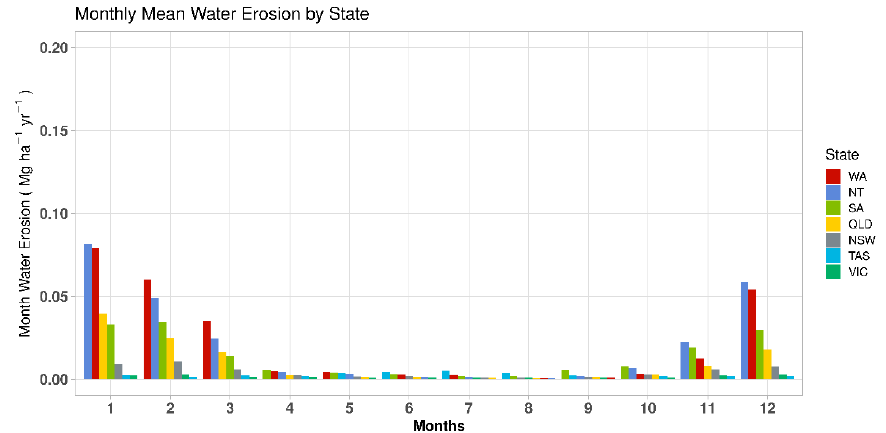
Figure 4. Monthly water erosion based on SILO in 2001–2020.